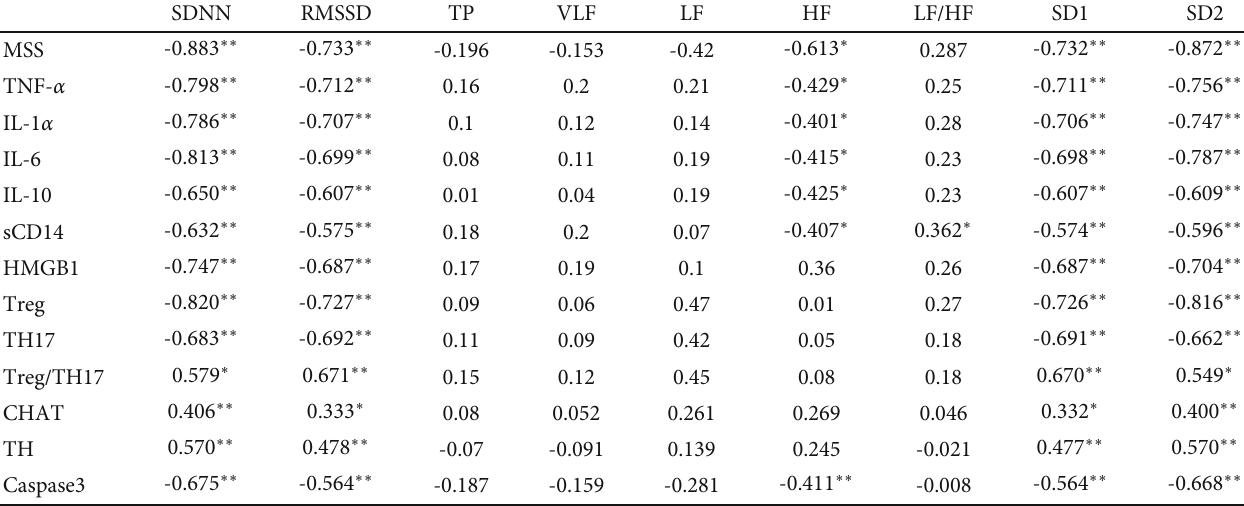
Table 3: Correlation analysis between HRV indexes and MSS, in fl ammatory cytokines, immune regulation, expression of CHAT, and